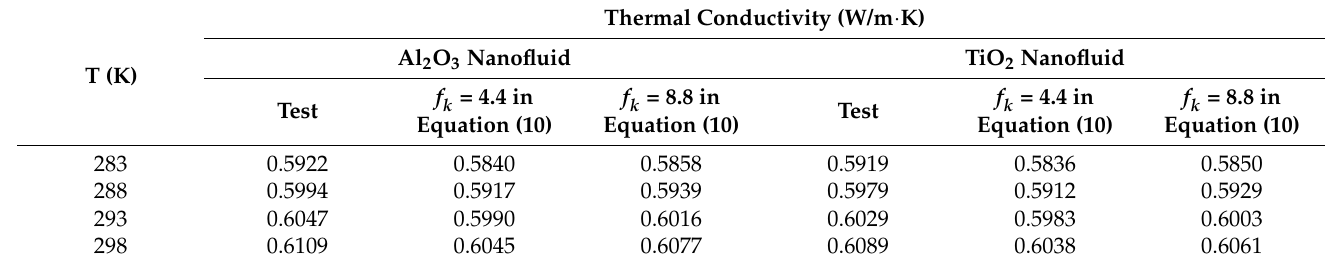
Table 2. Thermal conductivity for Al 2 O 3 and TiO 2 nanofluids (0.1 v%) with temperature.